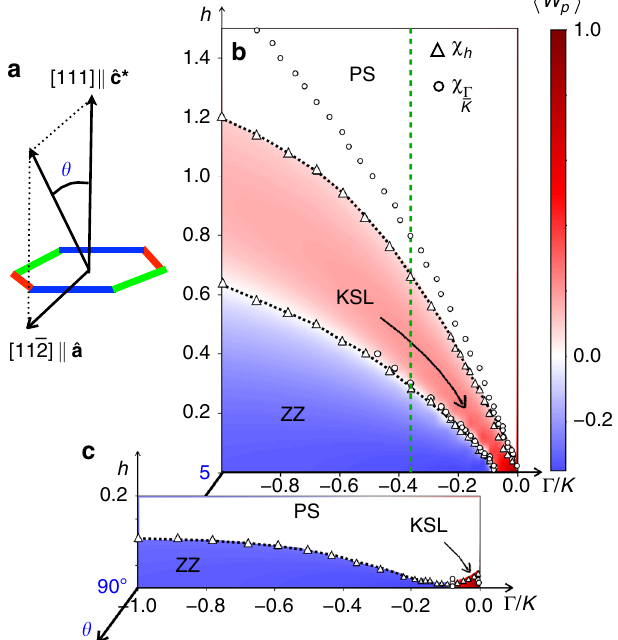
Fig. 1 ED phase diagrams. a The angle θ is measured from [111] towards the in-plane ½ 11 (cid:2) 2 (cid:6) direction. Phase diagrams in the Γ / K − h plane (FM Kitaev and AFM Γ ) obtained using ED on the 24-site honeycomb cluster are shown for b θ = 5° and c θ = 90° at a fi xed Γ ′ = − 0.03 in units of ffiffiffiffiffiffiffiffiffiffiffiffiffiffiffiffi p K 2 þ Γ 2 (cid:3) 1. Circular and triangular markers represent peaks in the susceptibilities χ Γ / K and χ h , respectively. The intermediate- fi eld KSL is adiabatically connected to the pure K limit at h = 0, as indicated by a black arrow inside the KSL. Colors represent the expectation value of the plaquette operator 〈 W p 〉 in the ZZ and KSL, but not in the PS for clarity, which is discussed further in the main text. A sequence of phase transitions from ZZ order to the KSL, and fi nally the PS is found for θ = 5°, except near the pure K limit. The green line in b at Γ / K ≃ − 0.37 denotes a representative slice where χ h and S ( q ) are plotted in Fig.